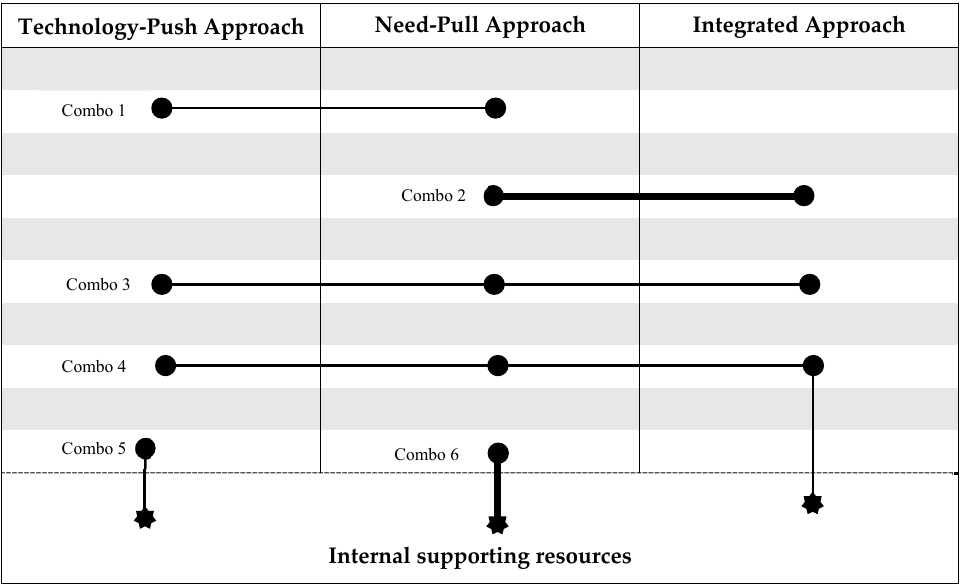
Table 12. Overview of the observed Industry 4.0 adoption driver combinations.